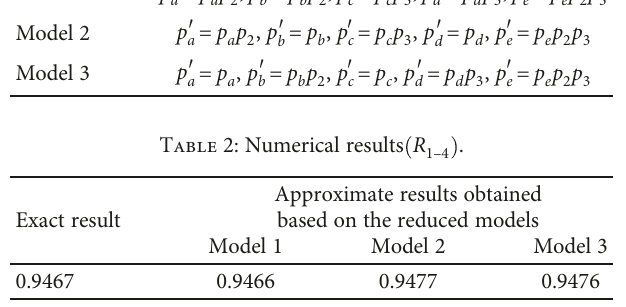
Figure 1: A simple network: (a) initial model; (b – d) reduced models.